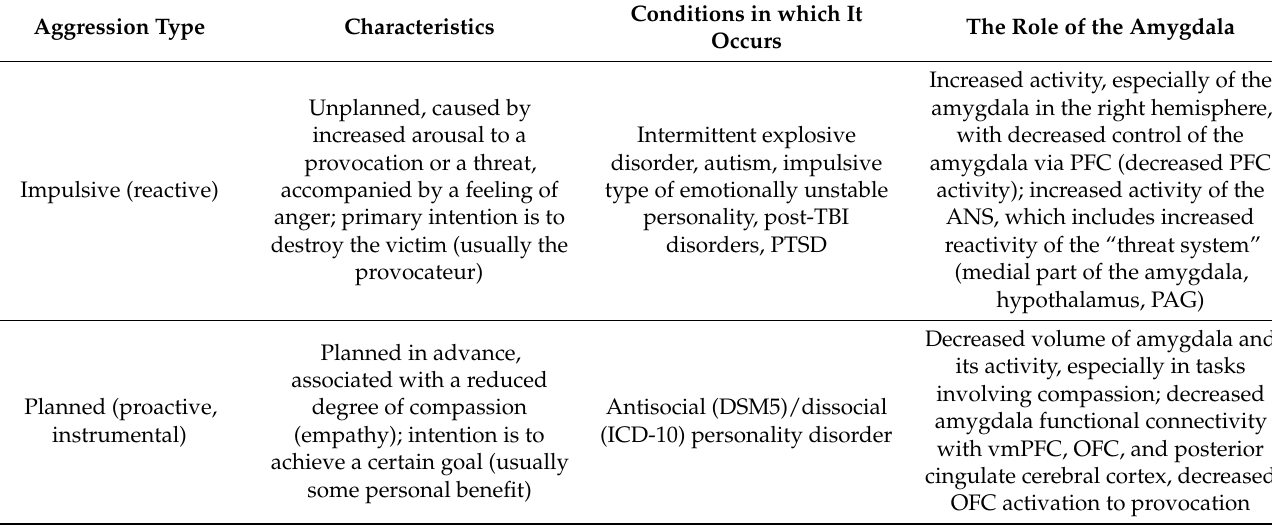
Table 1. Division and characteristics of the two main types of aggression, and the role of the amygdala. ANS—autonomic nervous system; OFC—orbitofrontal cortex; PAG—periaqueductal gray matter; PTSD—post-traumatic stress disorder; TBI—traumatic brain injury; vmPFC—ventromedial prefrontal cortex. Information according to Blair (2010) [215], Begi´c (2014) [216], Bogerts et al., (2018) [217], Farah et al., (2018) [218], and Gouveia et al., (2019)